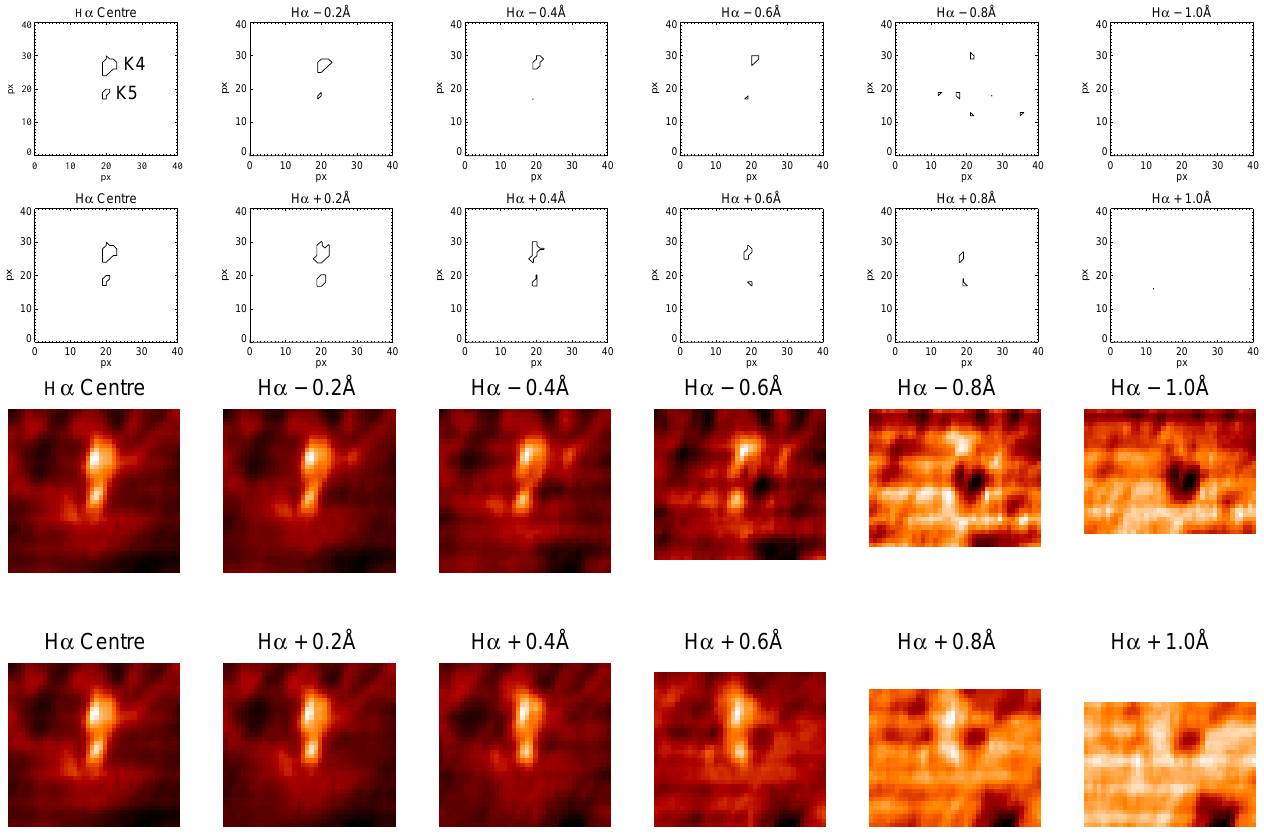
Fig. 3. B2.5 class solar flare (kernels K4 and K5) in NOAA 10603 active region observed at 07:24:33UT on 3 May 2004. The upper and lower panels are the same as on Fig. 1.